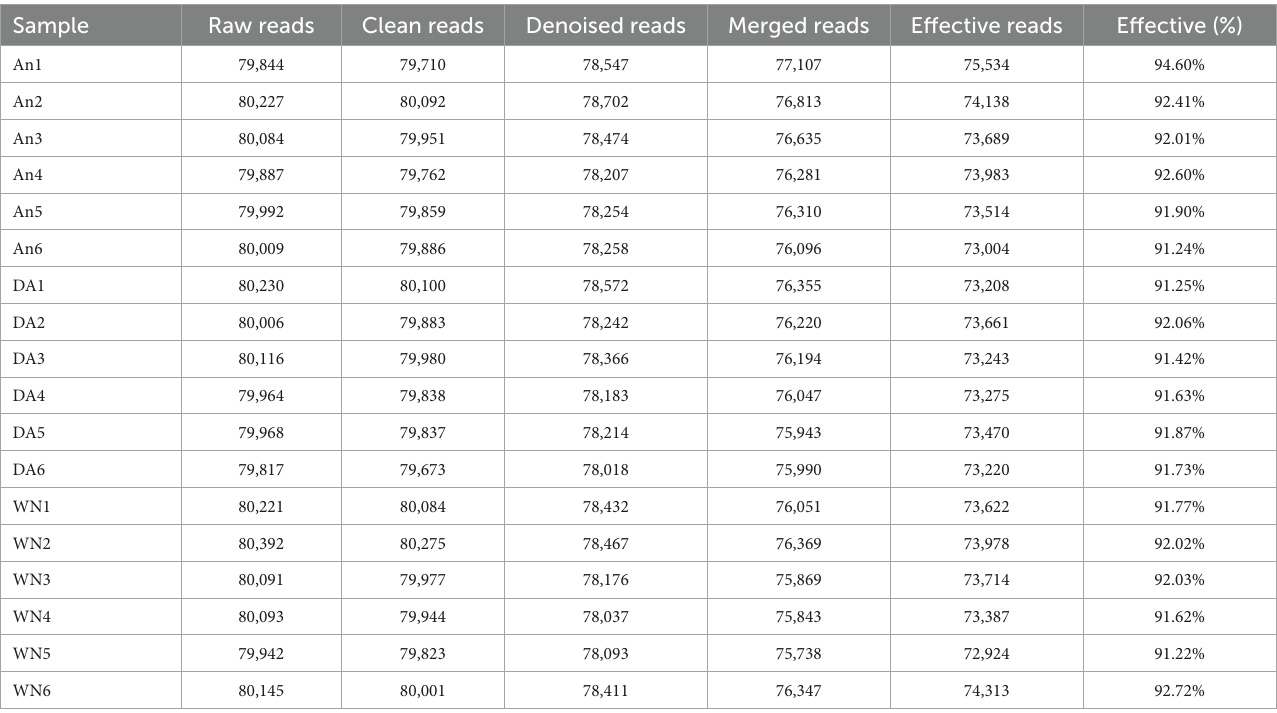
TABLE 1 The bacterial sequence information of each sample.